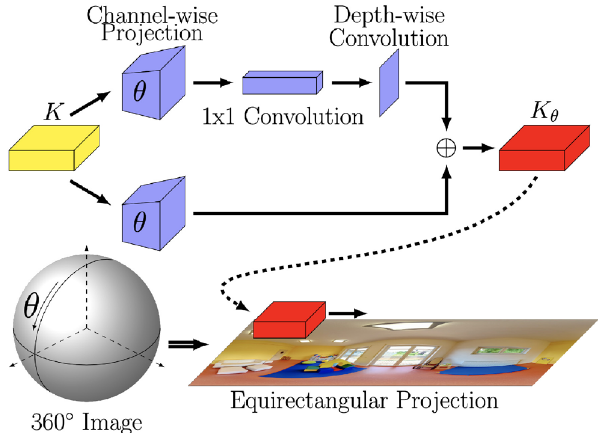
Fig. 8 Kernel transformer networks (KTN) for compact spherical convolution in 360 ◦ images. KTNs consist of row dependent channel- wise projections where the kernel is resized to the target size, and depth separable convolution blocks. A source kernel K and an angle θ are fed into the KTN to generate the output kernel K θ for convolution with the image in equirectangular projection. Reproduced with permission from Ref. [105], c (cid:2) Institute of Electrical and Electronics Engineers 2019.